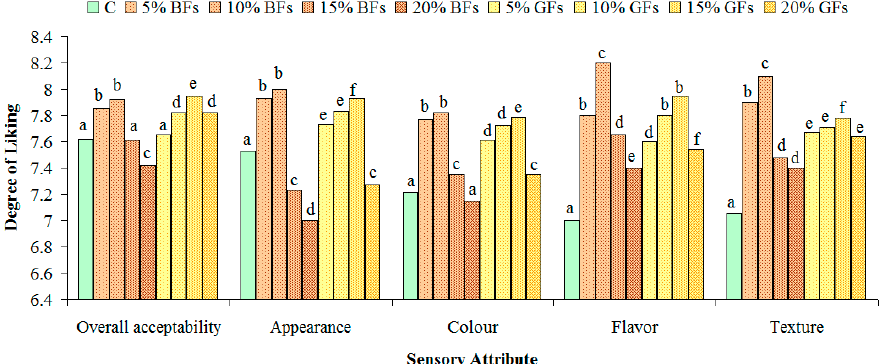
Figure 6. E ff ect of brown flaxseed (BFs) and golden flaxseed (GFs) at di ff erent addition levels: 0% (C), 5%, 10%, 15% and 20% on the sensory attributes of bread from a WF of a strong quality for bread-making. Means with di ff erent letters indicate significant di ff erence among treatments ( p < 0.05).